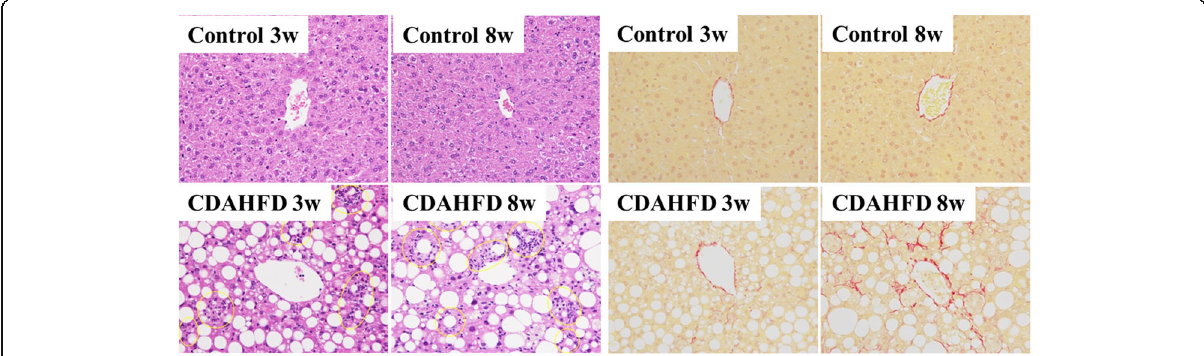
Fig. 1 Hepatic histopathology in mice fed a control or choline-deficient, L -amino acid-defined, high-fat diet (CDAHFD) for 3 or 8 weeks. Representative photomicrographs of hepatic histology stained with hematoxylin and eosin (H&E) (left) and Sirius red (right) (×200 magnification)